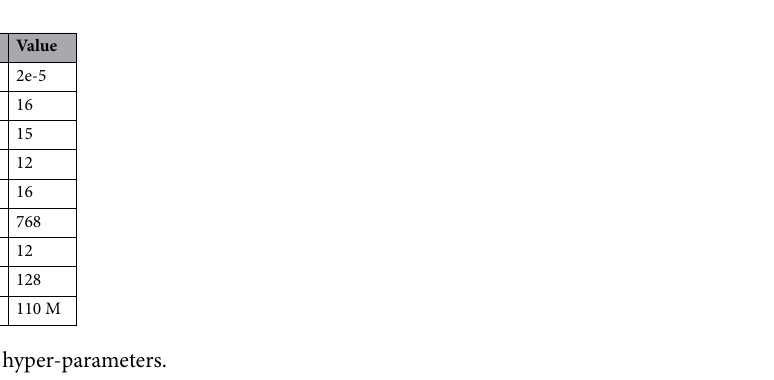
Fig. 4. The classification layer or softmax layer that has been added here. The classification layer has a dimension of K x H, where K is the number of classes (Positive, negative and neutral) and H is the size of the hidden state. Model Training and Fine-Tuning: The entire sentiment classification mBERT model has been trained in two phases, with the first phase involving the pre-training of the mBERT language model and the second phase involving the fine-tuning of the outmost classification layer.The Urdu mBERT has been pre-trained on the Urdu Wikipedia. The mBERT model has been fine-tuned using the training set of the proposed and UCSA datasets, which are Comprised with labelled user reviews. Especially, the fully connected classification layer has been trained in this way. During training, categorical cross-entropy was utilized as the loss function. Table 5 presents lists the hyper-parameters adopted for this research.